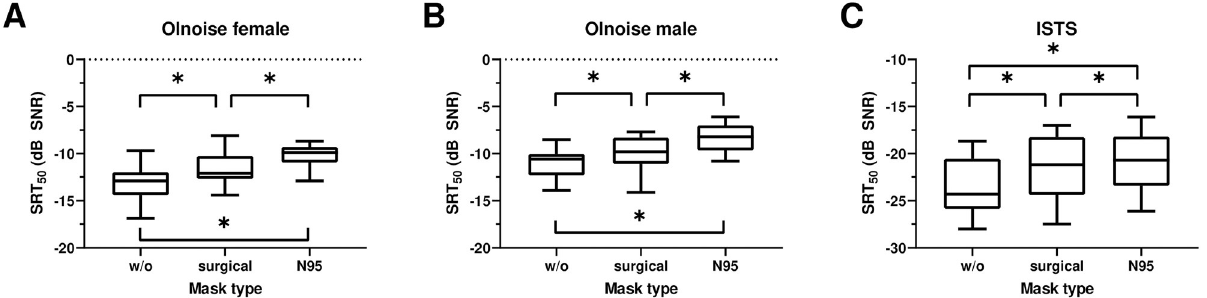
Fig 2. Distributions of speech perception in noise SRT 50 for the Oldenburg Sentence Test (OLSA) presenting speech and noise signals from a female speaker (A) and a male speaker (B), or a female speaker in International Speech Test Signal (ISTS) (C). Putting a surgical face mask or an N95 mask between the speaker and the listener reduced the performance, as reflected by an increased SRT 50 . Boxes show the 25th, 50th and 75th percentiles, and whiskers indicate the 5th and 95th percentiles. Asterisks ( � ) indicate significant differences ( p <